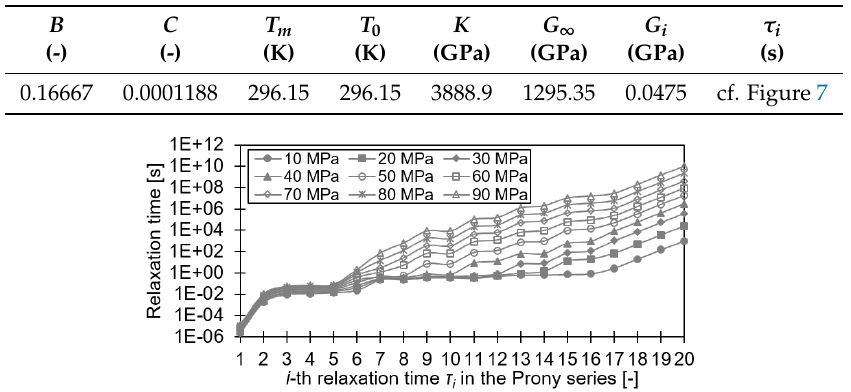
Table 2. Parameters of the modified van’t Hoff equation and Prony series for LY556 resin.